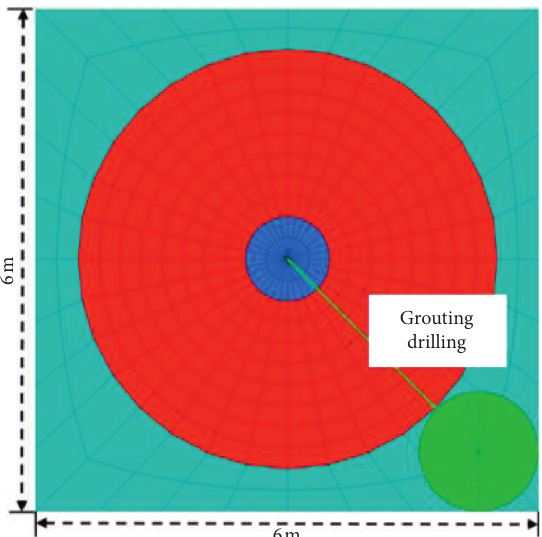
Figure 7: Grouting seepage simulation